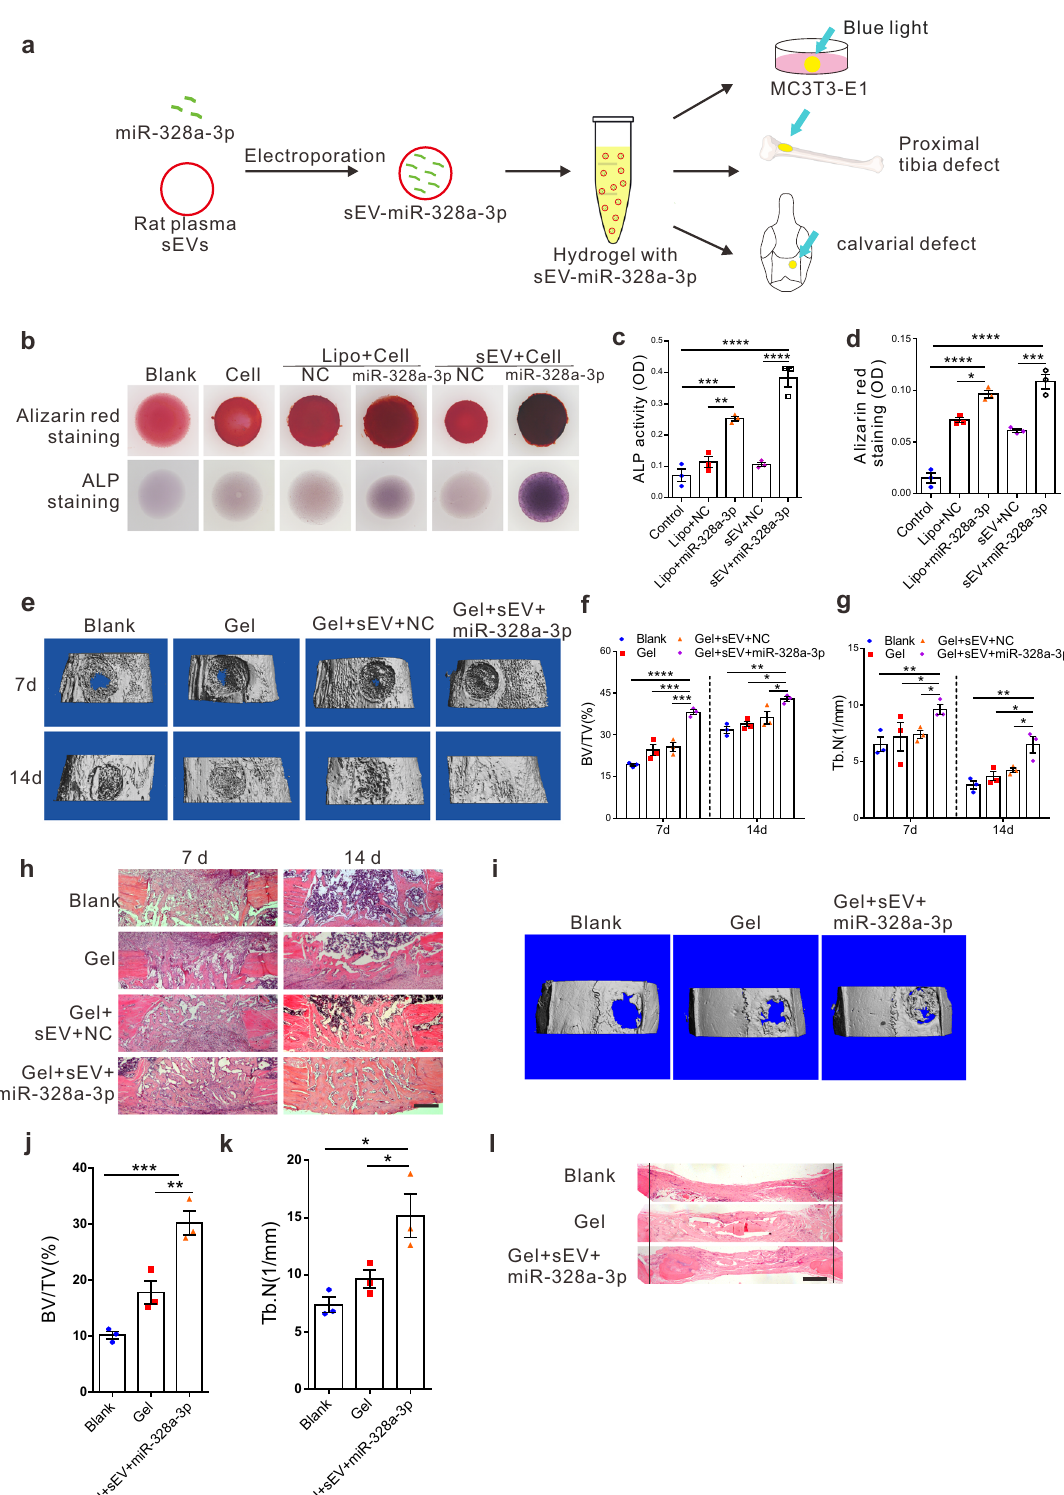
RNA isolation . RNA was extracted from cells using the QIAzol Lysis Reagent (Qiagen, Hilden, Germany) according to the user guidelines. Brie fl y, the cells were collected in a reaction tube, lysed with QIAzol, and mixed with chloroform. After being centrifuged at 12,000 × g for 15min at 4°C, the upper aqueous phase was transferred to an RNeasy Mini spin column in a 2mL collection tube and mixed with 100% ethanol. After being washed at 7500 × g for 5min at 4 °C, the total RNA was collected for qRT-PCR analysis. RNA was extracted from plasma and